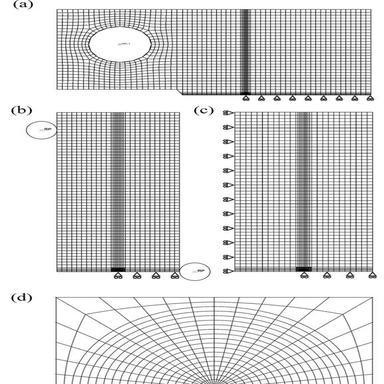
The mesh of stationary crack model for (a) CT, (b) SENB and (c) MT specimens, (d) refined mesh for crack tip.